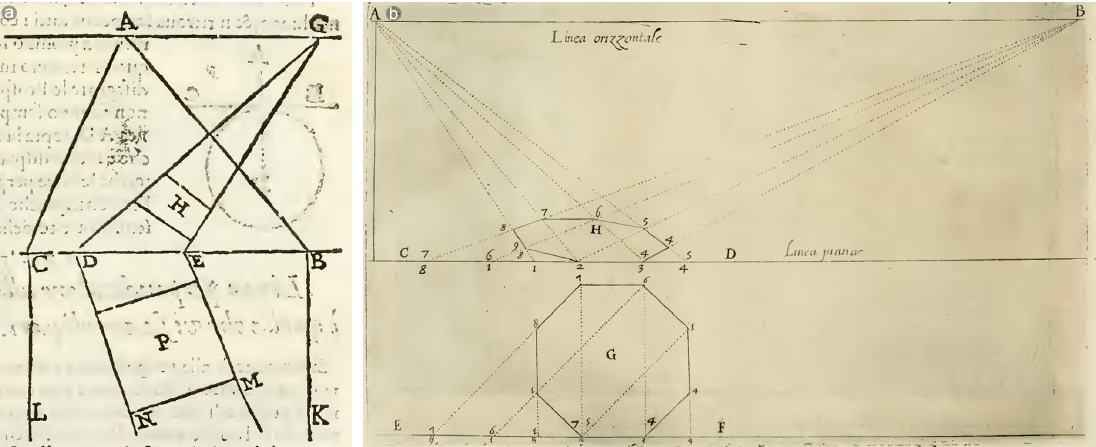
Figure 9. ( a ) Representation of straight lines that are not perpendicular or parallel to the picture plane (definition XI). These lines converge in a point located on the horizon; ( b ) Perspective of an octagon realized with the application of the second rule (VII chapter of second rule).